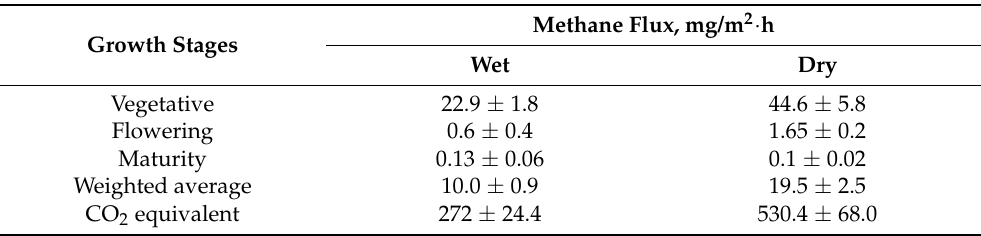
Table 4. Methane emission from CO 45 rice variety cultivated during successive wet and dry seasons at a field in Manjakuppam,